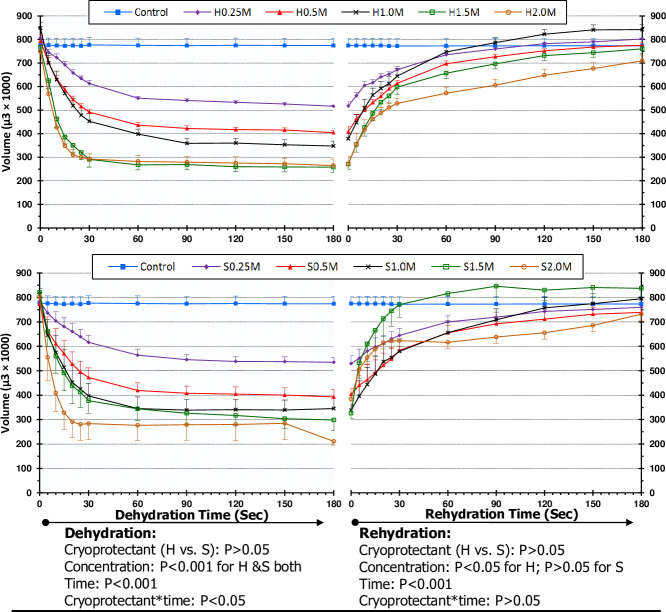
Effect of honey (H) and sucrose (S) concentrations (0.25, 0.5, 1, 1.5 and 2 M), time (0, 5, 10, 15, 20, 25, 30, 60, 90, 120, 150 and 180 s) and their interactions on ooplasm volume (μ3 × 1000) during dehydration and rehydration phases.Each point represents a mean ± SEM (n = 3 oocytes per treatment group per replicate × 3 replicates).